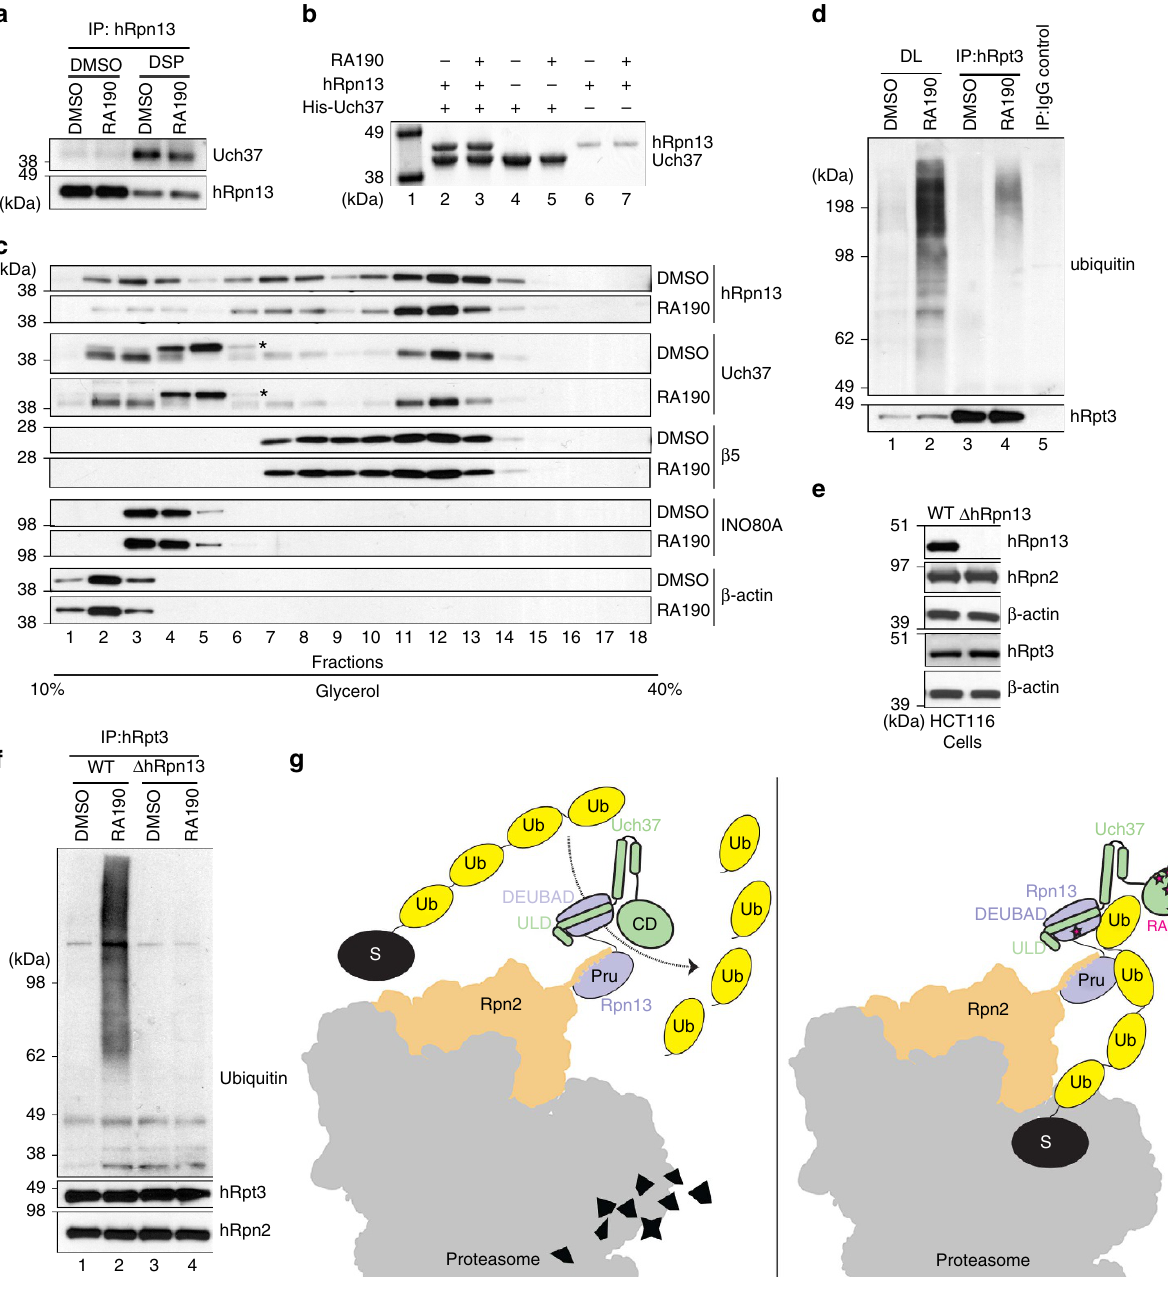
Figure 5 | RA190 treatment leads to accumulation of ubiquitinated species at the proteasome. ( a ) HCT116 cells were treated with 1 m M RA190 or DMSO for 24h and then further treated with the crosslinker DSP or DMSO as a control. Cell lysates were immunoprecipitated with anti-hRpn13 antibodies and immunoprobed with anti-Uch37 antibodies. ( b ) His-Uch37, hRpn13 or equimolar mixture of these two proteins at 2 m M were incubated with 20-fold molar excess RA190 or DMSO and then Talon resin. Retention of hRpn13 on the Uch37-bound resin was assessed by SDS–PAGE with Coomassie staining. Protein markers are included in lane 1. ( c ) HCT116 cell lysates treated with 1 m M RA190 or DMSO (as a control) for 24h were loaded onto a 10–40% linear glycerol gradient and subjected to ultracentrifugation. Gradient fractions were resolved by SDS–PAGE and immunoprobed with indicated antibodies. *Nonspecific band from the Uch37 antibody. ( d ) HCT116 cells were treated with 1 m M RA190 or DMSO control for 24h and lysates immunoprecipitated with anti-hRpt3 antibodies, followed by immunoblotting as indicated. Direct loads (DLs) were included as well as an IgG control for the DMSO-treated cells. ( e ) Wild-type (WT) or hRpn13-deleted ( D hRpn13) HCT116 cells were collected, lysed and immunoprobed as indicated, with b -actin as a loading control. ( f ) HCT116 WT and D hRpn13 cells were treated with 1 m M RA190 or DMSO control for 24h and lysates immunoprecipitated with anti-hRpt3 antibodies, followed by immunoblotting as indicated. hRpn2 was used as a control to confirm immunoprecipitation of proteasome subunits. ( g ) Proposed mechanism of action for RA190 at the proteasome. RA190 (pink star) targets the hRpn13 DEUBAD domain without abrogating hRpn13 (periwinkle blue) interaction with ubiquitin chains (yellow) or Uch37 (green). RA190 also targets and inactivates the Uch37 catalytic domain (CD), impairing ubiquitin chain disassembly and in turn ubiquitin release at hRpn13. A portion of the 26S proteasome is represented in grey with Rpn2 in orange and substrate in